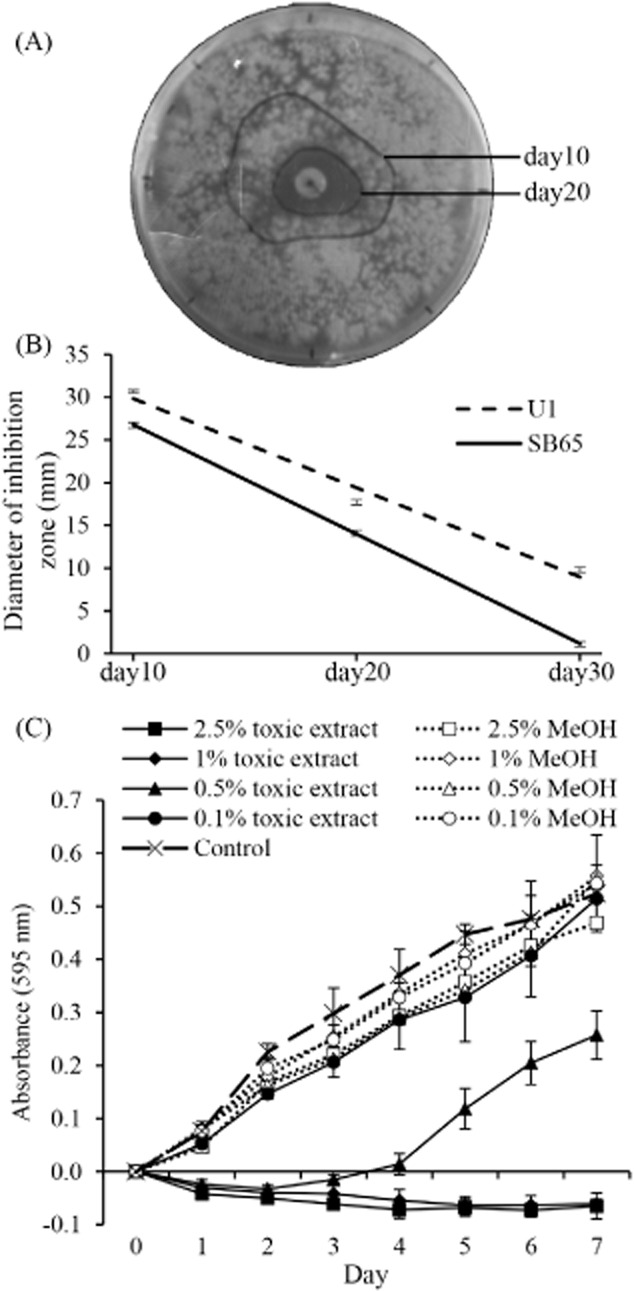
Inhibition of Agaricus bisporus growth by Trichoderma aggressivum toxic extract.A. With time, Agaricus colonized the zone of inhibition produced by T. aggressivum extract. The outer line demarcates the zone of inhibition after 10 days and the inner line after 20 days incubation with a paper disc impregnated with extract.B. The zone of inhibition was smaller for SB65 than for U1 at all three measurements and SB65 was able to overcome the toxicity faster than U1 (n = 10).C. In a microtiter plate assay, extract concentration at 0.1% v/v had no effect on growth, at 0.5% Agaricus was initially inhibited by the extract but was able to overcome toxicity, and at > 1%, Agaricus did not grow (n = 4).